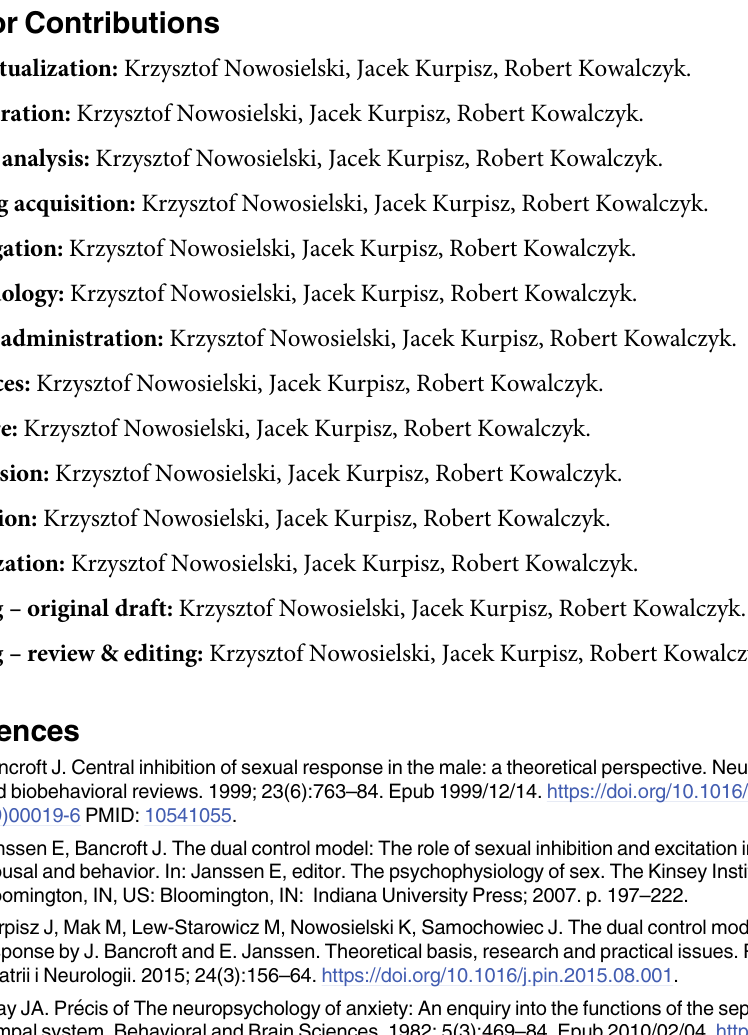
S1 Table. Correlations between the SESII-W-PL and other variables (Pearson’s r correla-